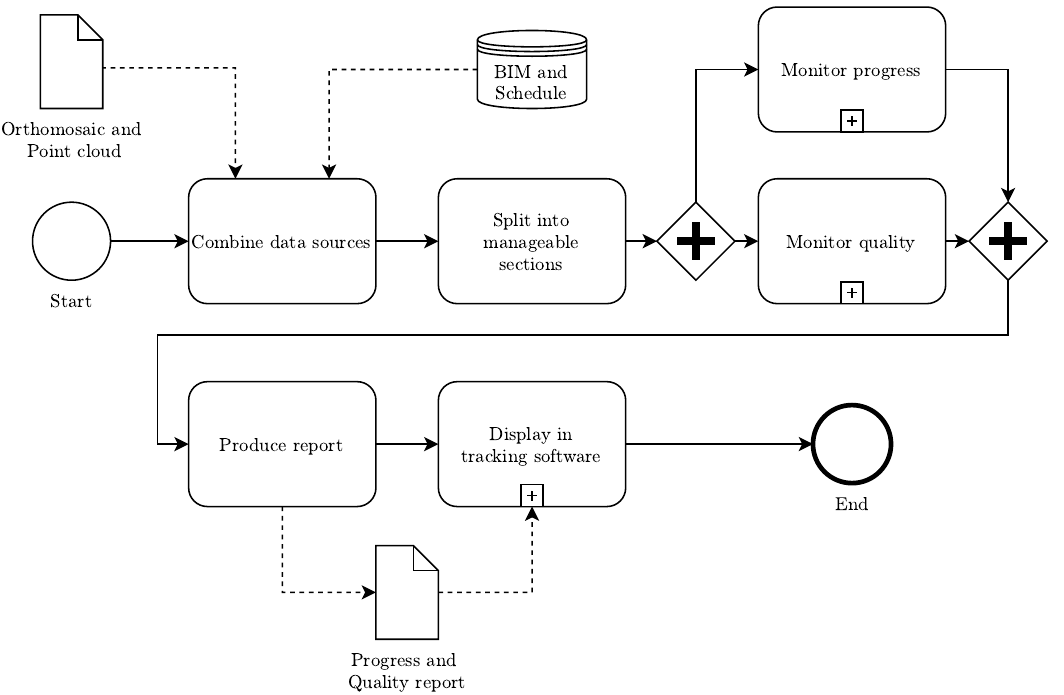
Figure 5. Data analysis workflow.